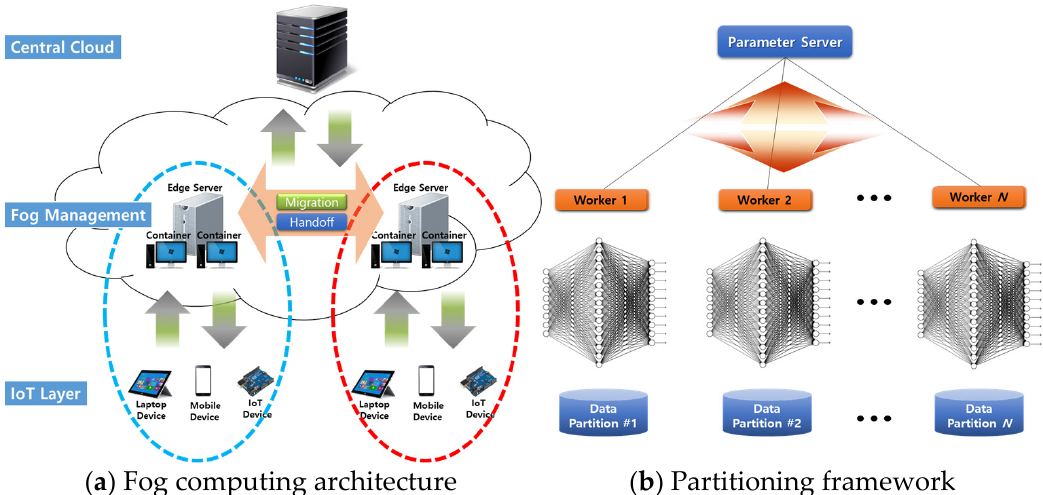
Figure 1. Fog computing architecture and partitioning framework.